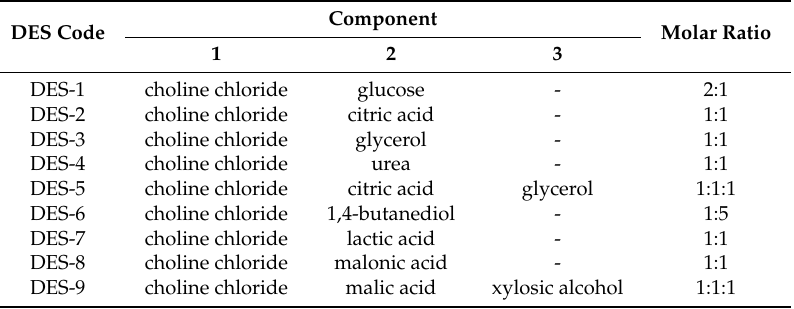
Table 1. Employed DES